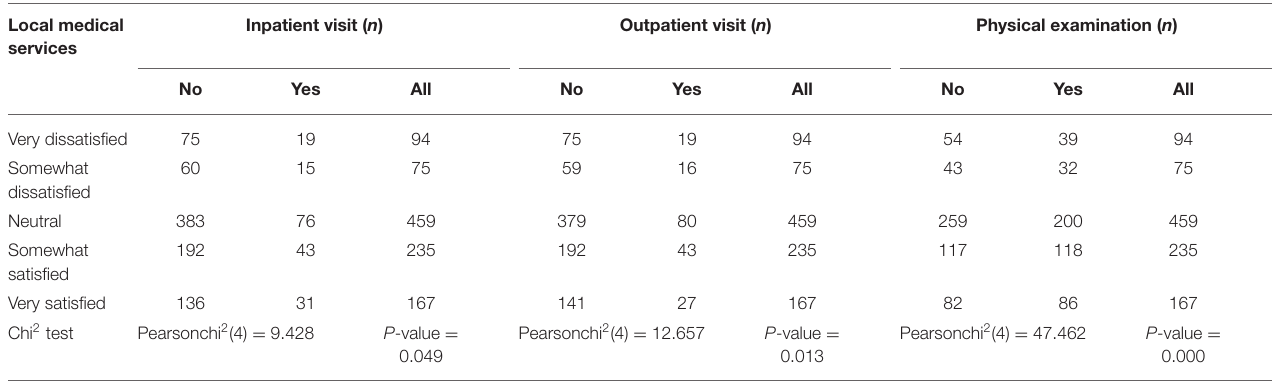
TABLE 2 | Chi-squared test for independence of satisfaction of local medical services and healthcare utilization. Local medical